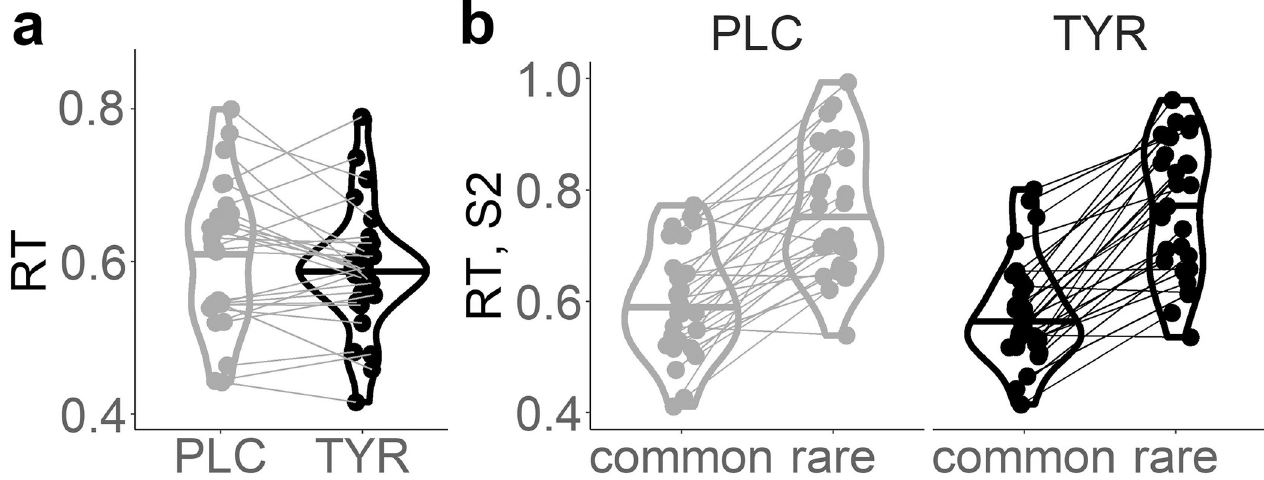
Fig 3. Violin plots of (A) median response times (RT) over both stages S1 & S2, and of (B) RTs in S2 subsequent to a common vs. a rare state transition from the sequential reinforcement learning task per supplementation condition (placebo vs. tyrosine).